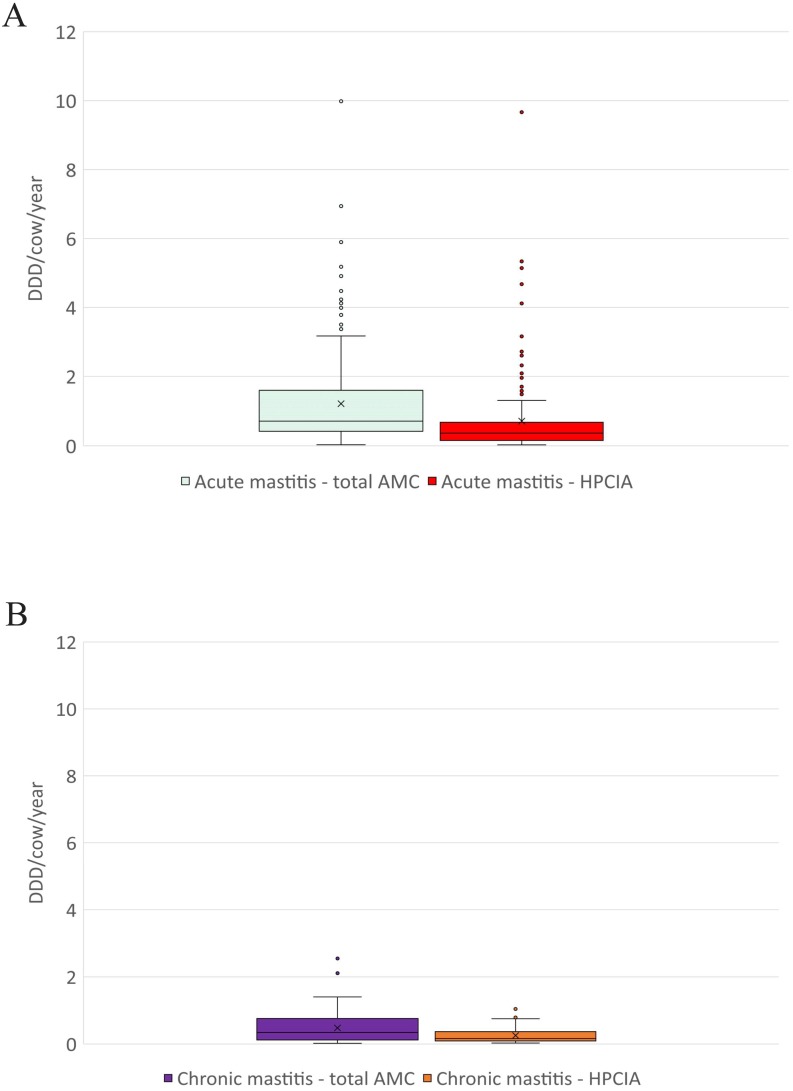
The distribution of the number of Defined Daily Doses (DDDvet) per cow and year by individual herd for reported diagnoses of (A) acute mastitis and (B) chronic mastitis—for total AMC and for HPCIA.AMC, antimicrobial consumption; HPCIA, highest priority critically important antimicrobials. Box, the range between the 1st (Q1) and 3rd (Q3) quartile; horizontal line, median; x, mean; lower whisker, Q1−1.5(IQR) (interquartile range); upper whisker, Q3 + 1.5(IQR); dots, outliers.